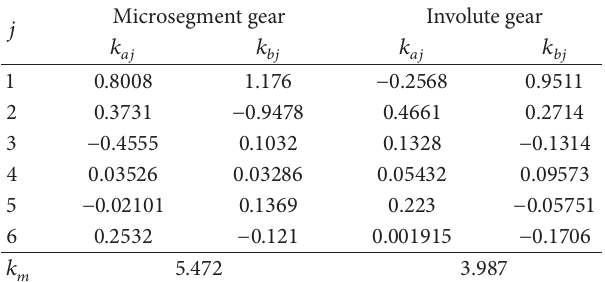
Table 2: Each harmonic parameter of meshing stiffness ( 10 8 N/m).